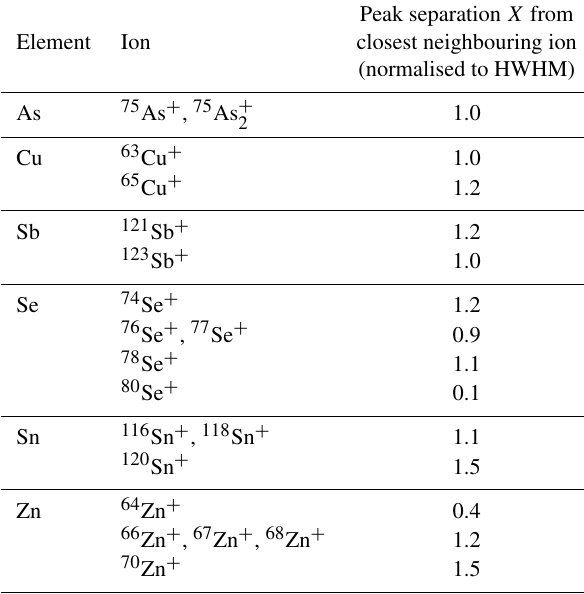
Table 3. Peak separation X , normalised to HWHM, of various met- als ions from neighbouring ions for instrumental mass resolving power of m/(cid:49)m = 450. Peak separation X from Element Ion closest neighbouring ion (normalised to